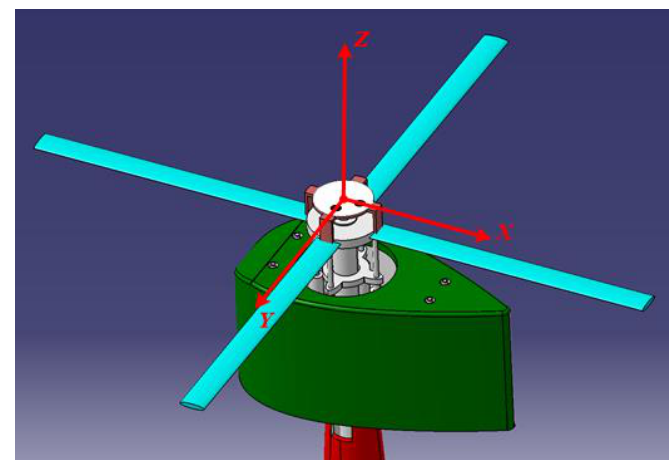
Figure 10. Rotor coordinate system.